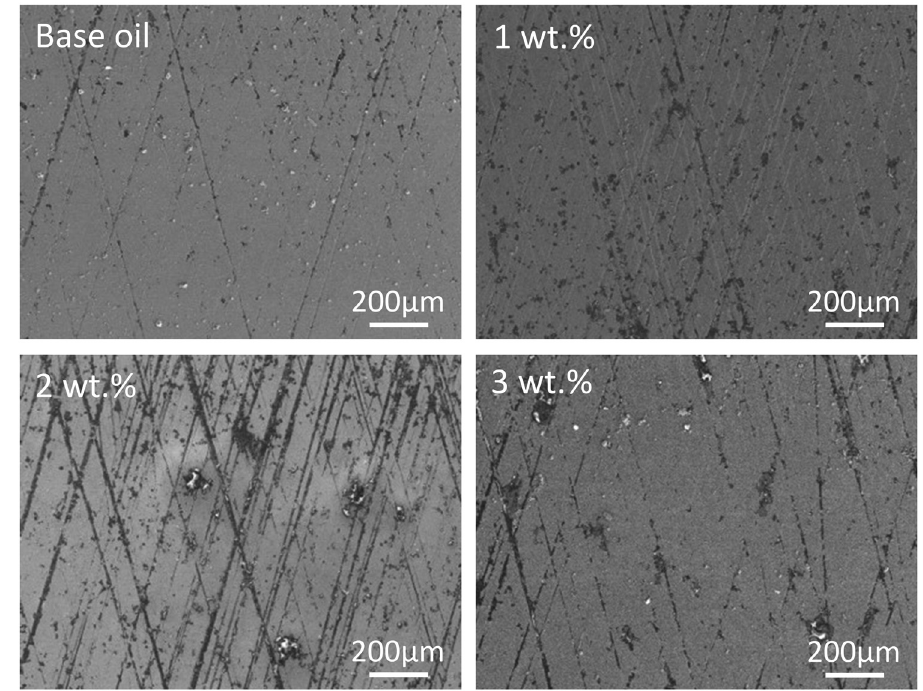
Figure 9: Surface morphology of nitriding cylinder liner under long - time wear test of 200°C.